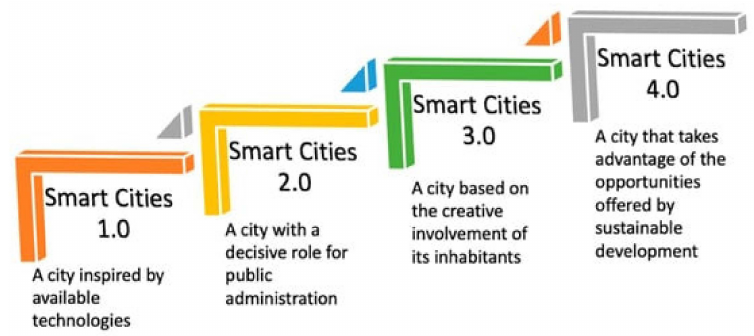
Figure 1. Next stages of development of smart cities. Source: Own study on the basis of